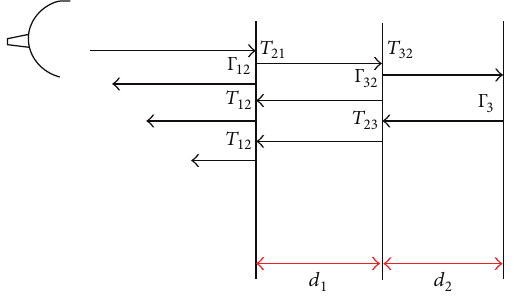
Figure 6: Multilayer test